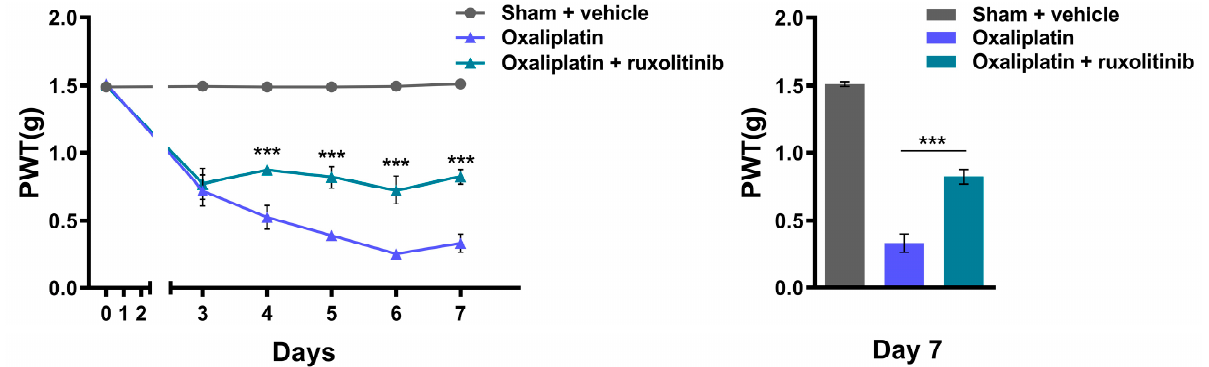
Figure 4. PWT of oxaliplatin-treated mice with intraperitoneal administration of ruxolitinib measured by mechanical allodynia testing using von Frey filament, and PWT measurement on the 7th day (n = 5). Oxaliplatin-treated mice compared to oxaliplatin with ruxolitinib-treated mice. Results are presented as the mean ± SEM (*** p < 0.001, ANOVA followed by Bonferroni post hoc test).